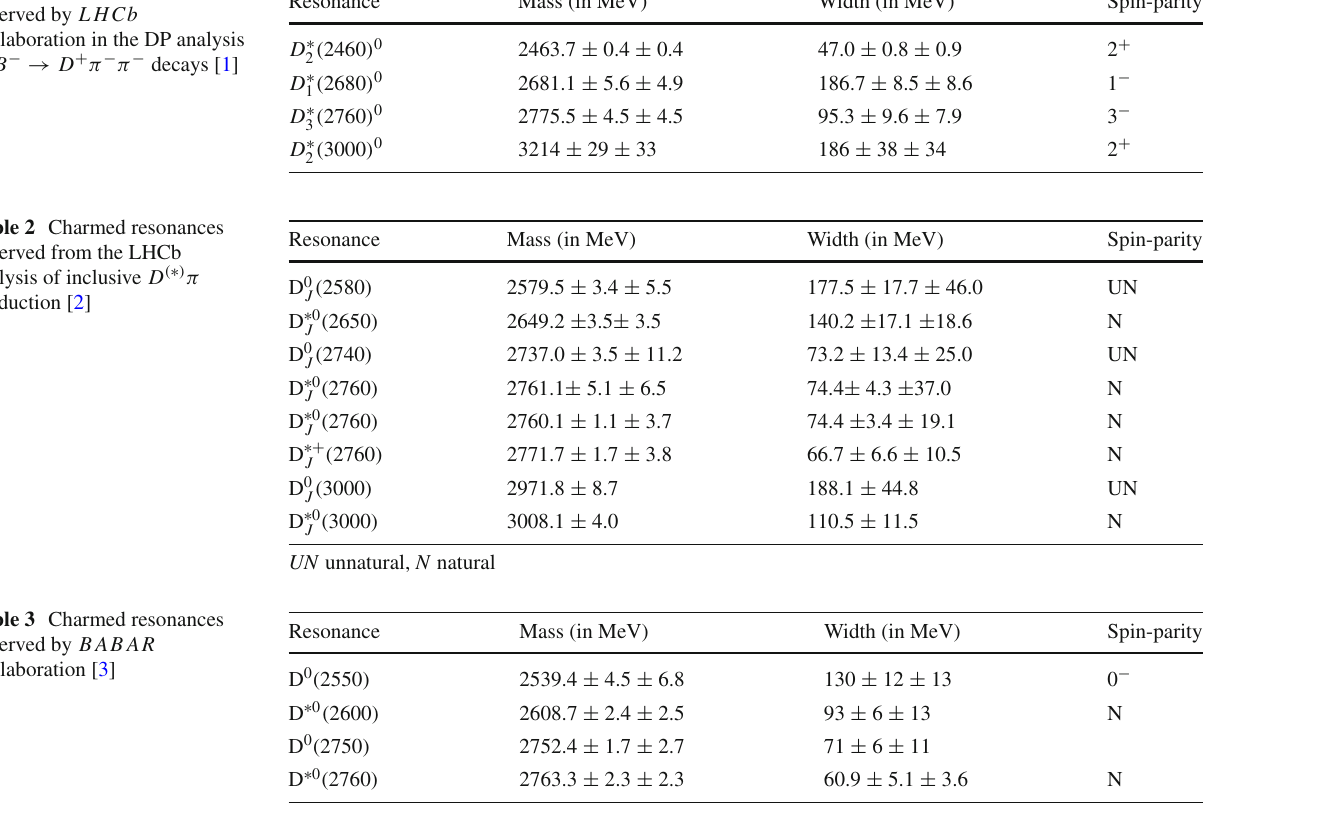
observed by LHCb Collaboration in the DP analysis of B − → D + π − π − decays [1]